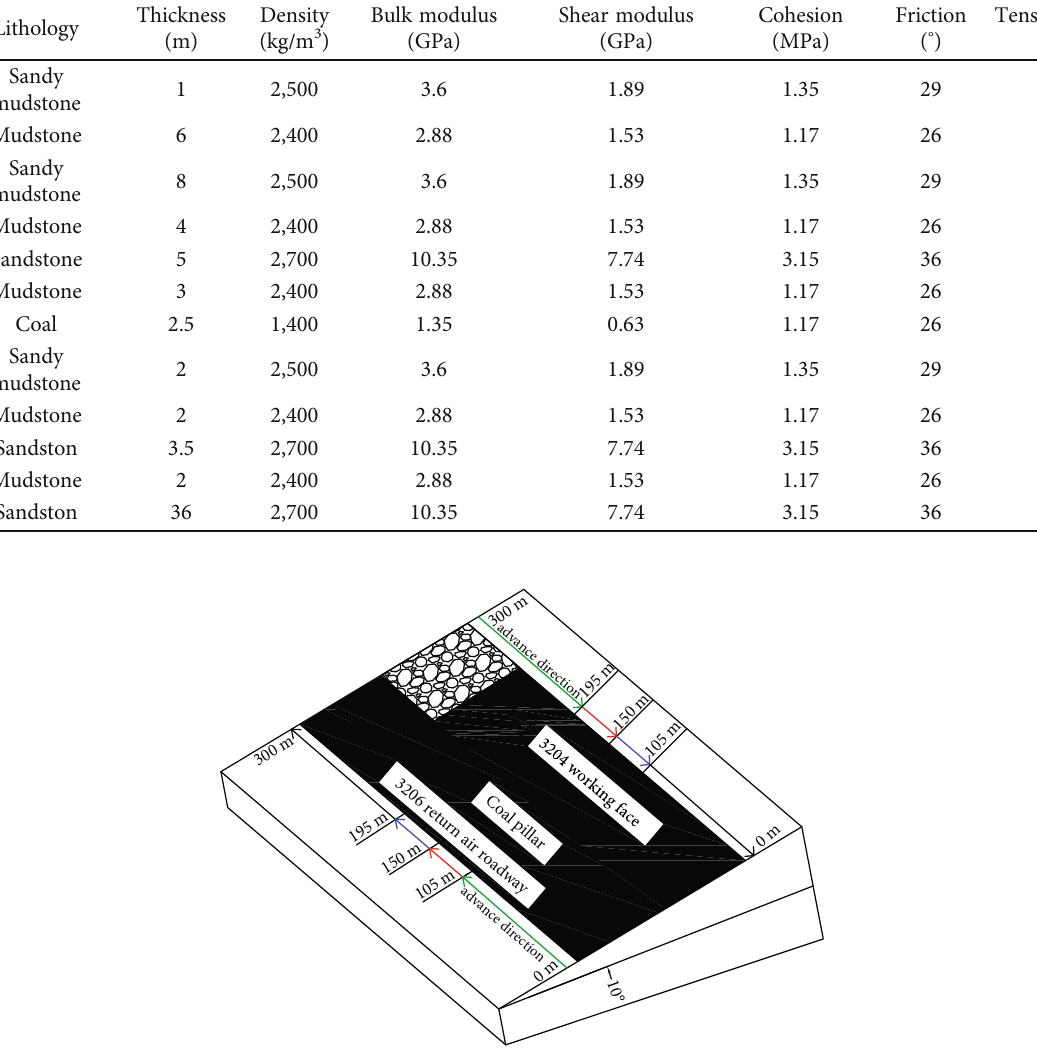
Table 1: Rock distribution and mechanical parameters.